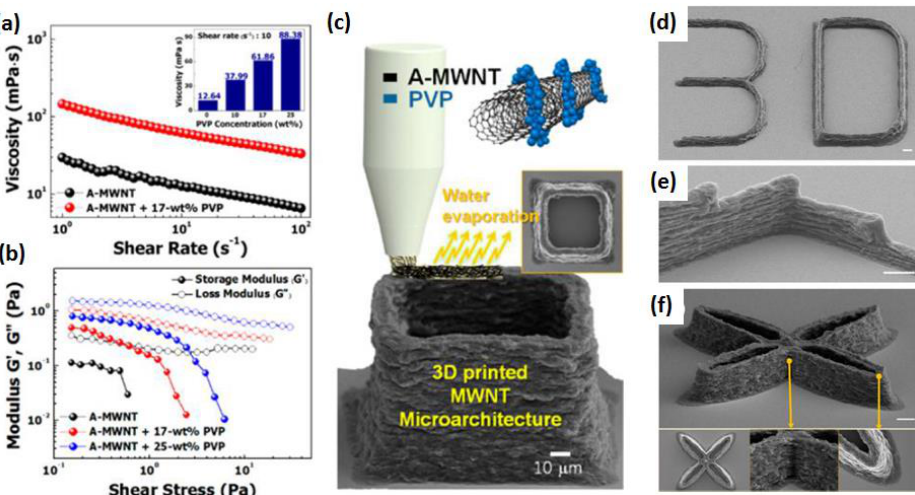
Figure 6. ( a ) Viscosity as a function of shear rate and ( b ) storage and loss moduli as functions of ink shear stress. (( a ), Inset) Histogram comparing viscosities of CNT inks with 7 wt. % A-MWNT and different PVP concentrations (0, 10, 17, 25 wt. %). The viscosity at a 10 s −1 shear rate increases gradually from 12.64 to 88.38 mPa·s; ( c ) Schematic diagram of 3D-printing process based on meniscus-guided printing. A 3D square MWNT microarchitecture (FE-SEM image) is printed by horizontally pulling a micronozzle filled with CNT ink (PVP-wrapped A-MWNT suspended in water), with water evaporating from the ink meniscus during the nozzle pulling. ( d – f ) FE-SEM images of 3D wall architectures with different shapes: ( d ) “3D” shaped wall (thickness (t) = 10 μm and height (h) = 24 μm); ( e ) Four-stair structure with orthogonal feature (t = 10 μm, h = 48 μm); ( f ) Three-dimensional cross-shaped structure with elliptical hollow feature (t = 10 μm, h = 40 μm). All scale bars are 20 μm. Reprinted (adapted) with permission from [82]. Copyright (2016) American Chemical Society.